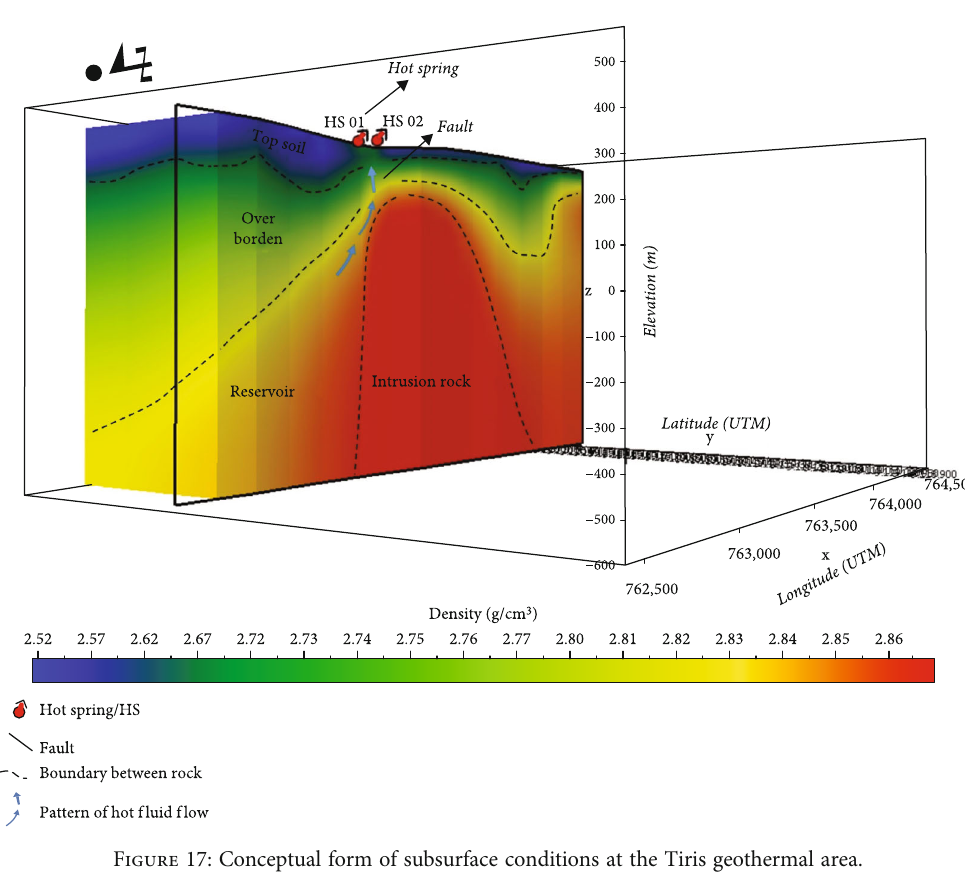
Figure 16: Map of residual Bouguer anomaly.